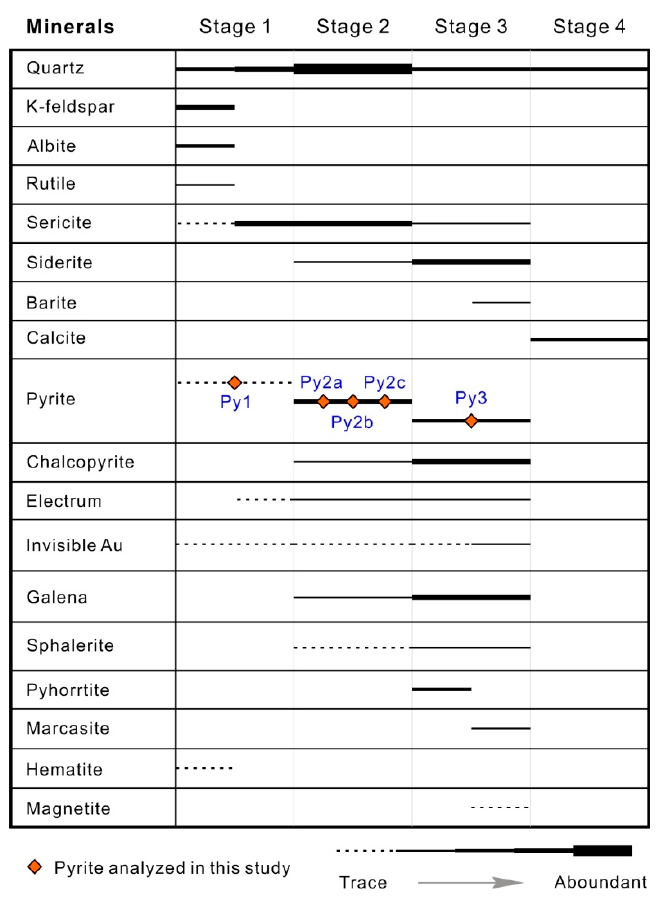
Figure 4. Paragenetic sequence of major minerals in the Sizhuang deposit.